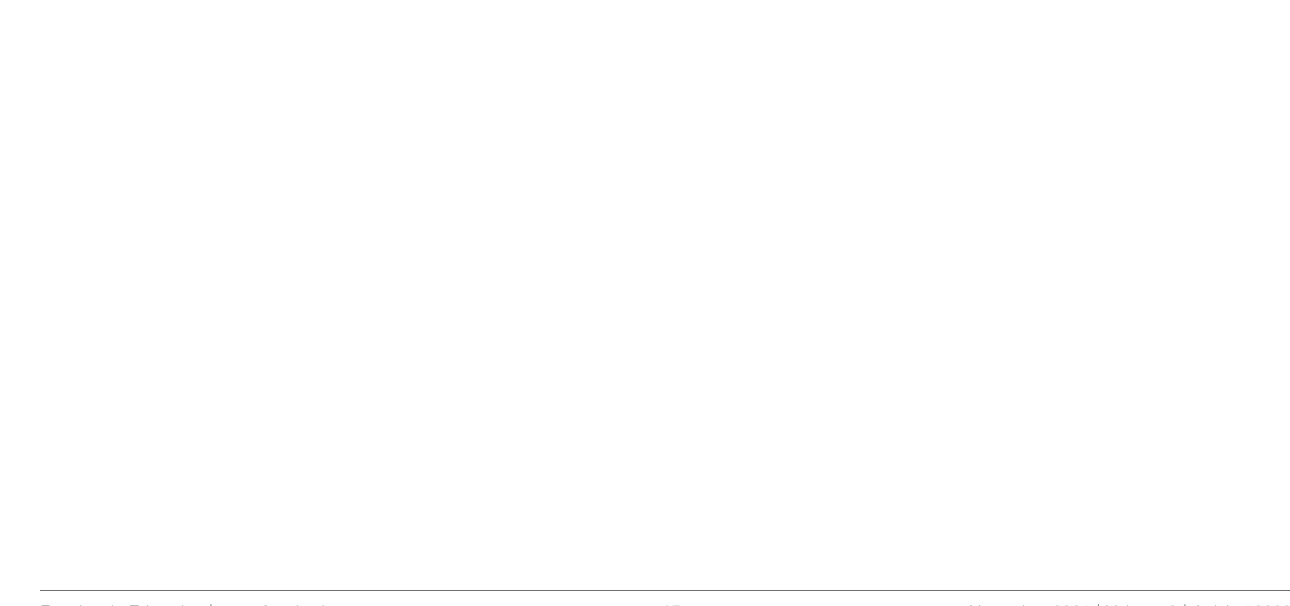
Frontiers in Education |